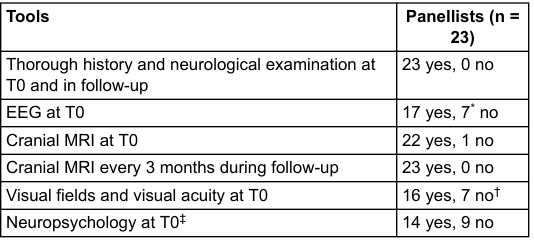
Figure 1: Sites of the SwissNOS panellists.